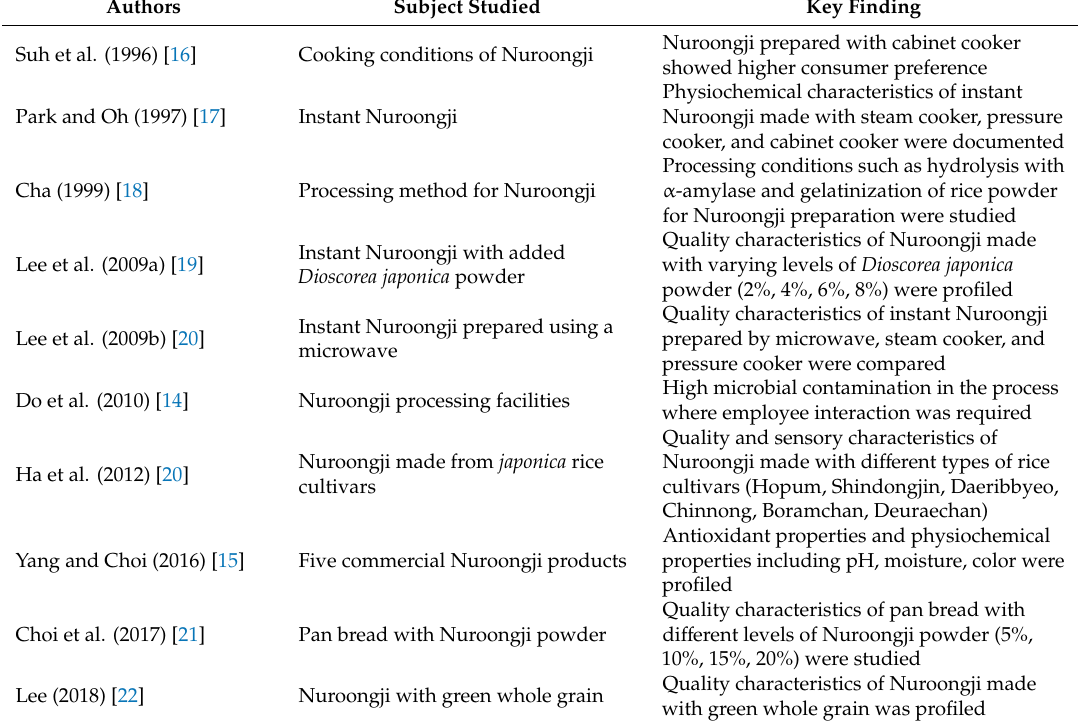
Table 1. Summary of previous research on Nuroongji